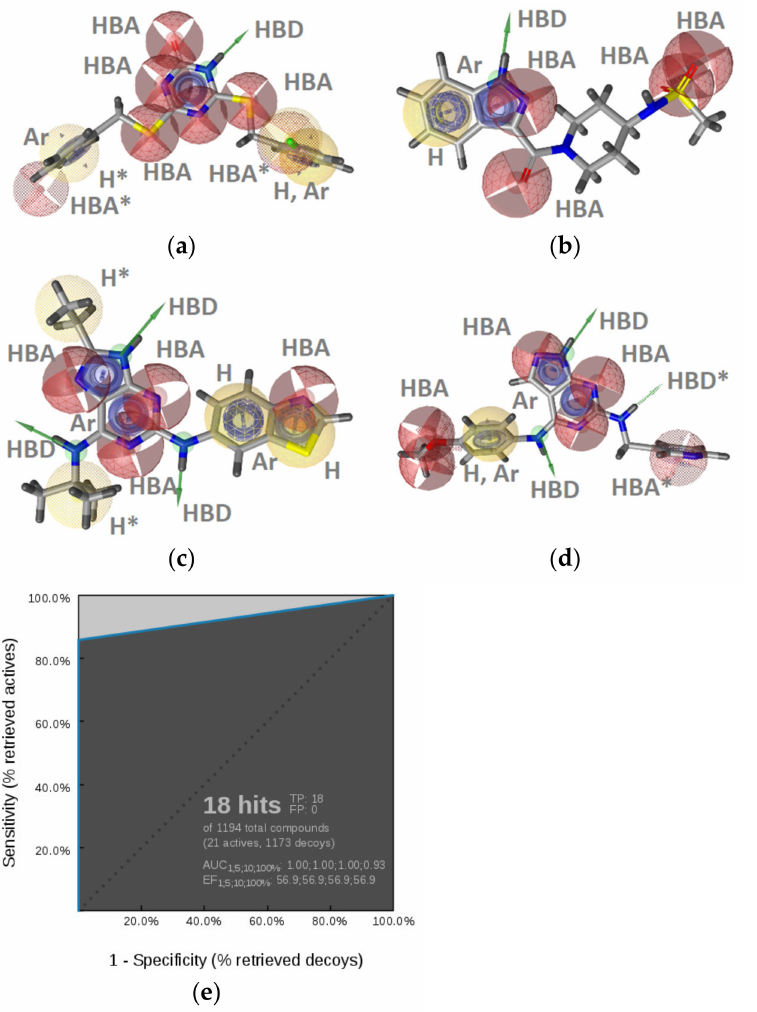
Figure 12. TopoII inhibitor ligand-based pharmacophore models: ( a ) LB-TopoII-Model-1 , ( b ) LB- TopoII-Model-2 , ( c ) LB-TopoII-Model-3 , and ( d ) LB-TopoII-Model-4 . The pharmacophore features are as follows: hydrophobic (H, yellow spheres), aromatic (Ar, blue disc), hydrogen bond donor (HBD, green arrow), and hydrogen bond acceptor (HBA, red sphere). Optional pharmacophore features are marked with *. ( e ) Receiver operating characteristic (ROC) curve resulting from parallel virtual screening of the TopoII active and decoy datasets with the 4 TopoII inhibitor 3D-pharmacophore